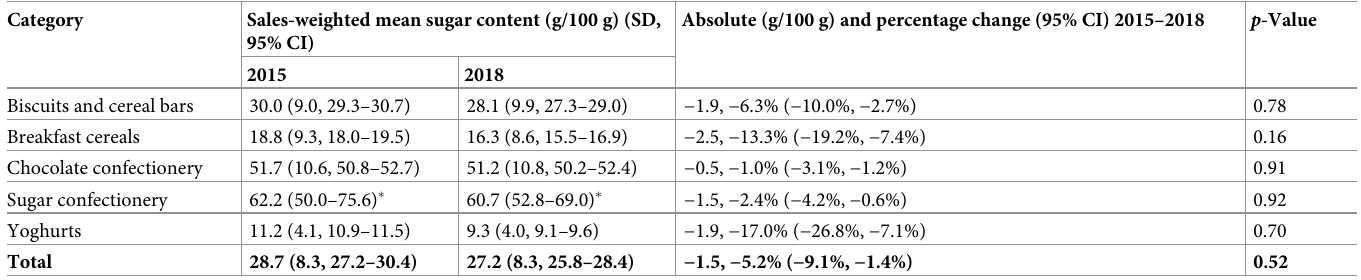
Table 4. The sales-weighted mean sugar content of food categories, 2015–2018.